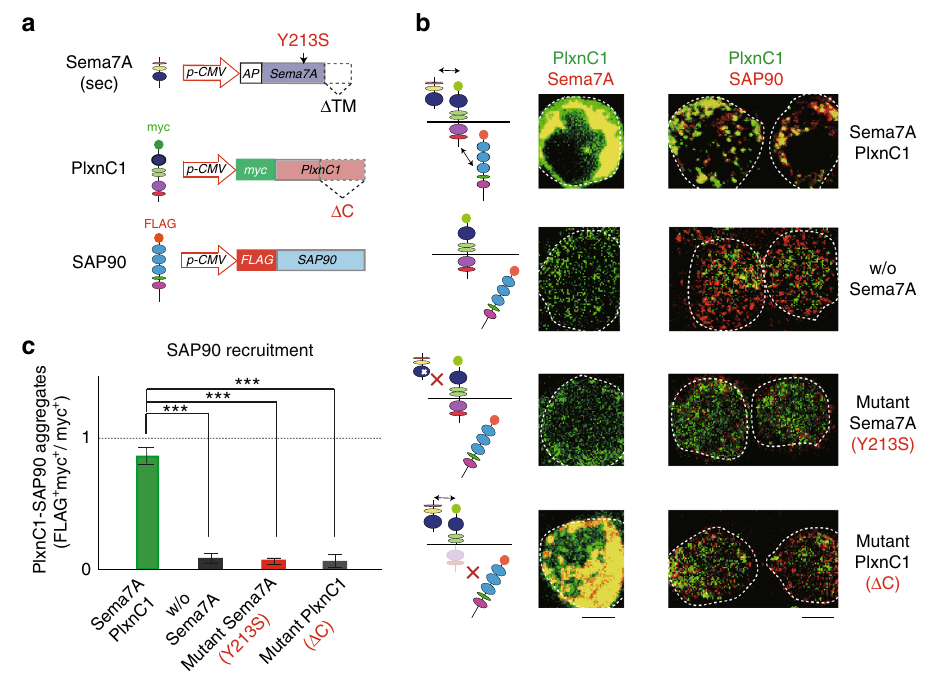
Fig. 7 Reconstitution of Sema7A – PlxnC1 interaction in the HEK cells. a Schematic diagrams of vector constructs. Plasmid structures are illustrated for the secreted form of Sema7A, myc -tagged PlxnC1 , and FLAG -tagged SAP90 . Y213S mutation in Sema7A and Δ C deletion in PlxnC1 are indicated. b Co- expression of Sema7A, PlxnC1 and SAP90 in HEK cells. Secrete-form Sema7A , myc -tagged PlxnC1 and FLAG -tagged SAP90 genes were introduced into the HEK293 cells in culture. Structures of Sema7A, PlxnC1, and SAP90 are schematically shown (left). Cell-surface expression of Sema7A and PlxnC1 was separately analyzed by immunostaining (middle). To detect SAP90 and PlxnC1, cells were immunostained with antibodies against epitope tags FLAG and myc, respectively (right). When the secrete-form Sema7A was co-expressed, clustering of the PSDwas induced. Co-expression of mutant Sema7A, Y213S, blocked PSD formation. PSD formation was also blocked with the mutant PlxnC1, Δ C. HEK cells are circled. Scale bars = 10 μ m. c Formation of SAP90 aggregates with PlxnC1. Yellow-stained aggregate-signals (PlxnC1 bound SAP90) are compared among the four different experiments, shown in b . Aggregate formation was calculated as myc + FLAG + dots (yellow)/all myc + dots (green and yellow). *** p < 0.005 (Student ’ s t -test). Error bars indicate